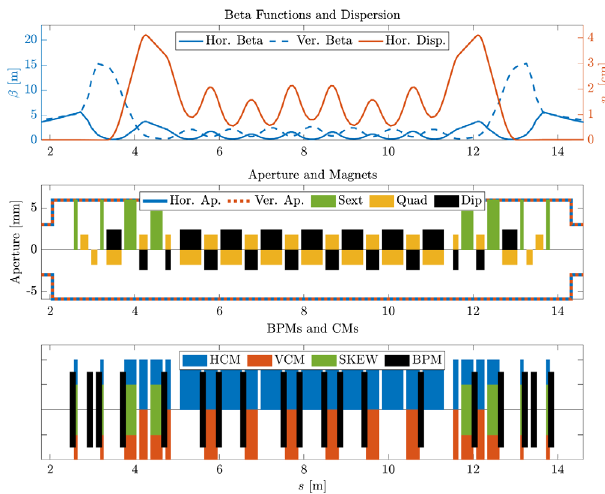
FIG. 1. Lattice and magnet layout in a normal (i.e., without hard bends) sector. Shown are the betatron and the dispersion functions (top), the aperture model, and the distribution of magnets (center) and the distribution of corrector magnets, skew quadrupole correctors, and beam-position monitors (bottom). The center figure emphasizes that all quadrupoles, except for the two pairs at each end, provide some degree of